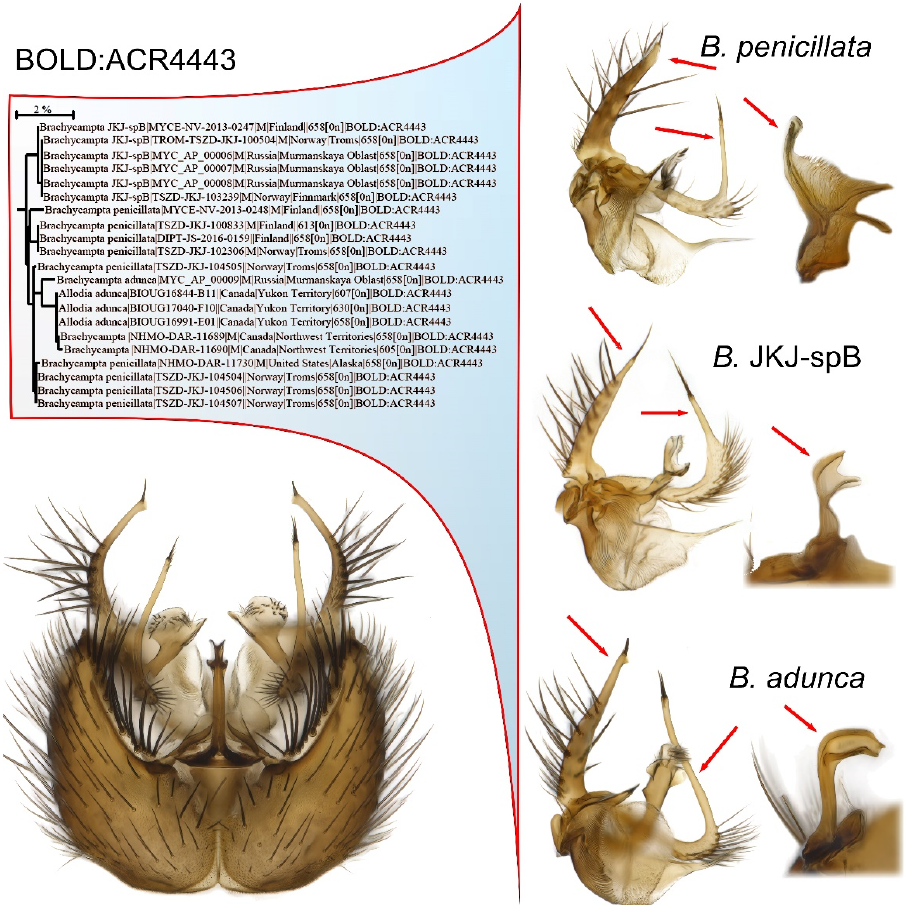
Figure 6. Example of BIN sharing of three morphologically distinct species. The Brachycampta adunca -complex merged two described species and one considered to be new to science into the same BIN, BOLD:ACR4443. Within the BIN the three morphotype species are only partly resolved for Brachycampta JKJ-spB while Brachycampta adunca Zaitzev, 1992 is nested within Brachycampta penicillata (Lundstrom, 1912). This complex belongs to the genus Brachycampta Winnertz, 1864, recently reinstated by Magnussen et al. [79], thus the sensu lato genus name Allodia Winnertz, 1864, is still used by other BOLD users. The images depict the male terminalia of Brachycampta adunca in ventral view and details of the gonostylus and hypandrial lobe for the three involved species to the right.